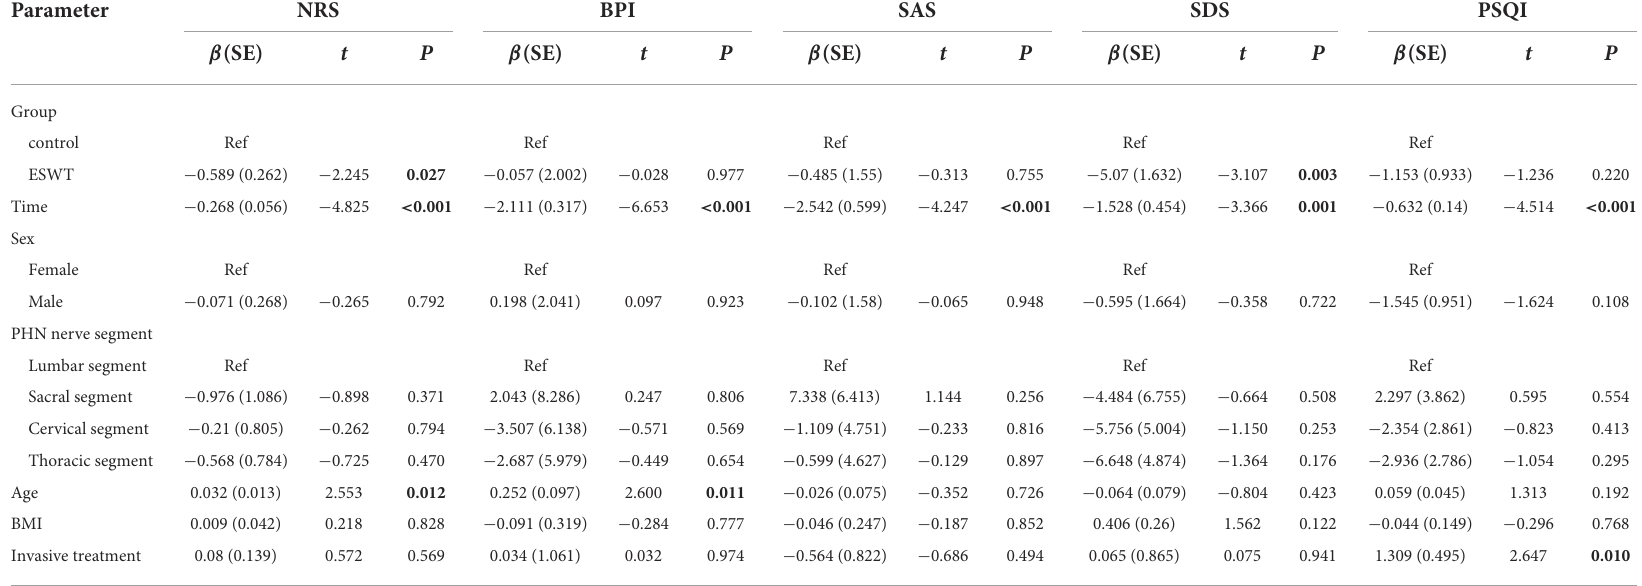
TABLE 4 Longitudinal change in scores for intervention related to the control group from baseline through 12 weeks.